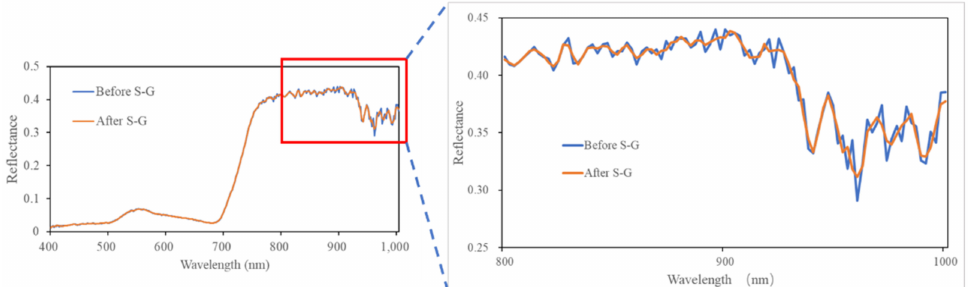
Figure 2. Comparison of crop spectra before and after S–G filtering.